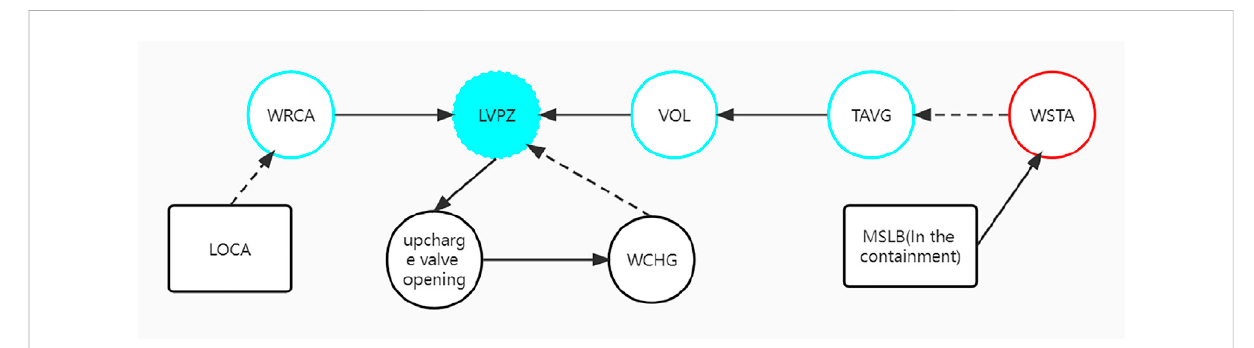
FIGURE 10 SDG model of the water level control system of the